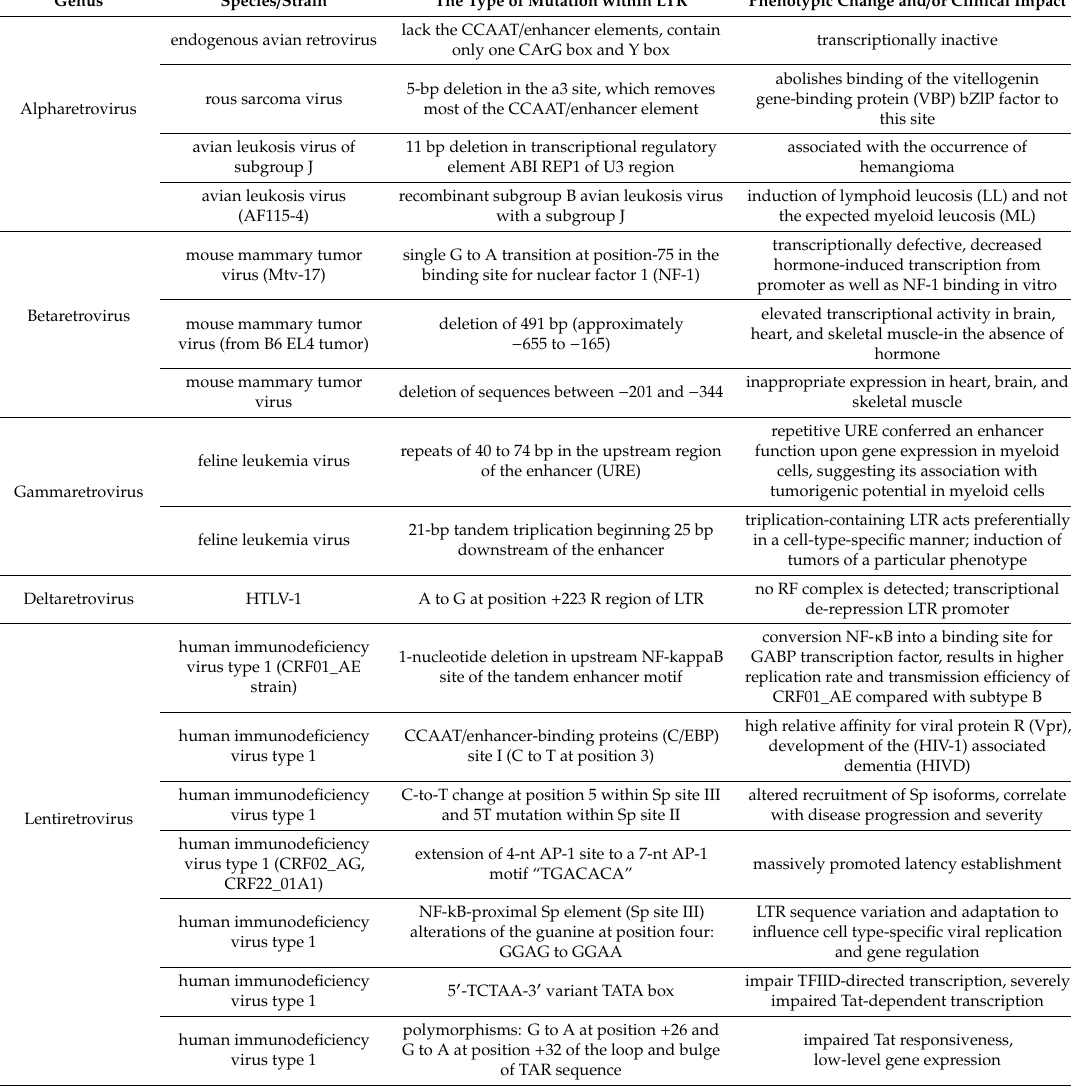
Table 1. Examples of sequence variation in the LTRs of select retroviruses and their impact on phenotypic change and clinical